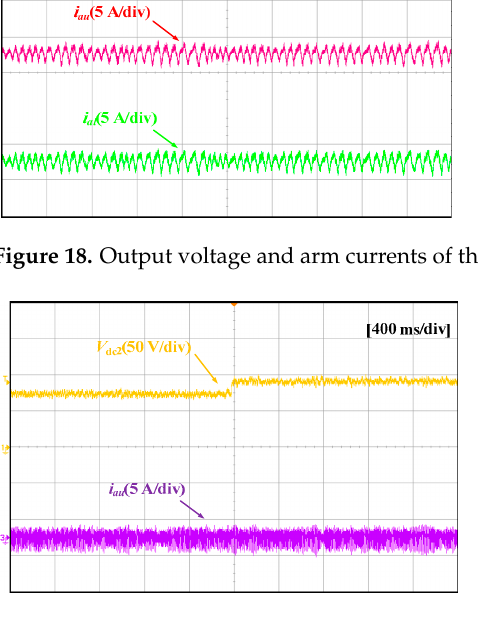
Figure 19. The DC output voltage and arm current of the proposed DC-DC MMC with a step voltage change from 80 V to 100 V.